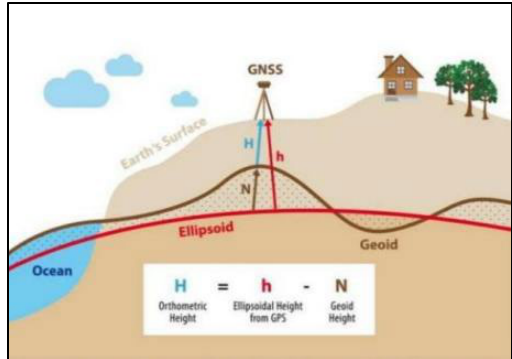
Figure 7. Relationship between ellipsoidal, orthometric and geoid heights (Albayrak et al.,